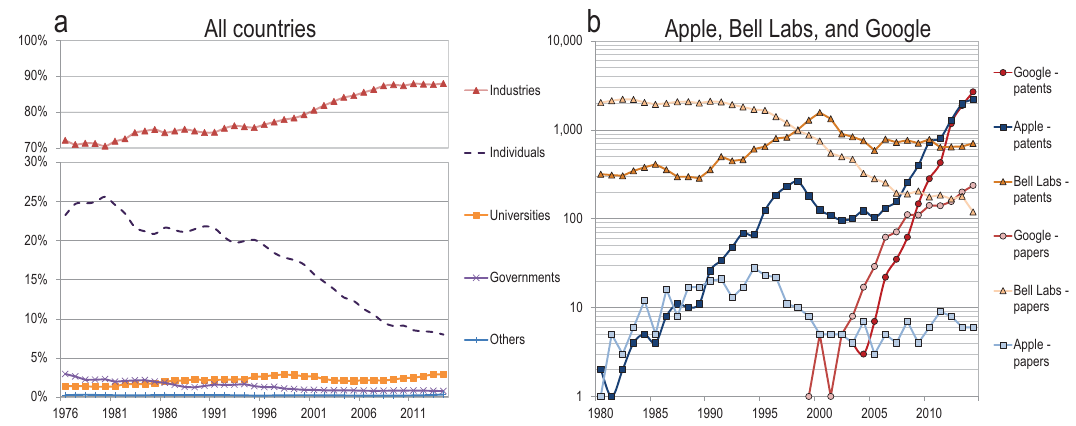
Fig 5. (a) Share of patent ownership (USPTO) by institutional sector, all countries, 1976–2014, (b) number of papers published and patents owned, Apple, Bell Laboratories (and various owners) and Google,